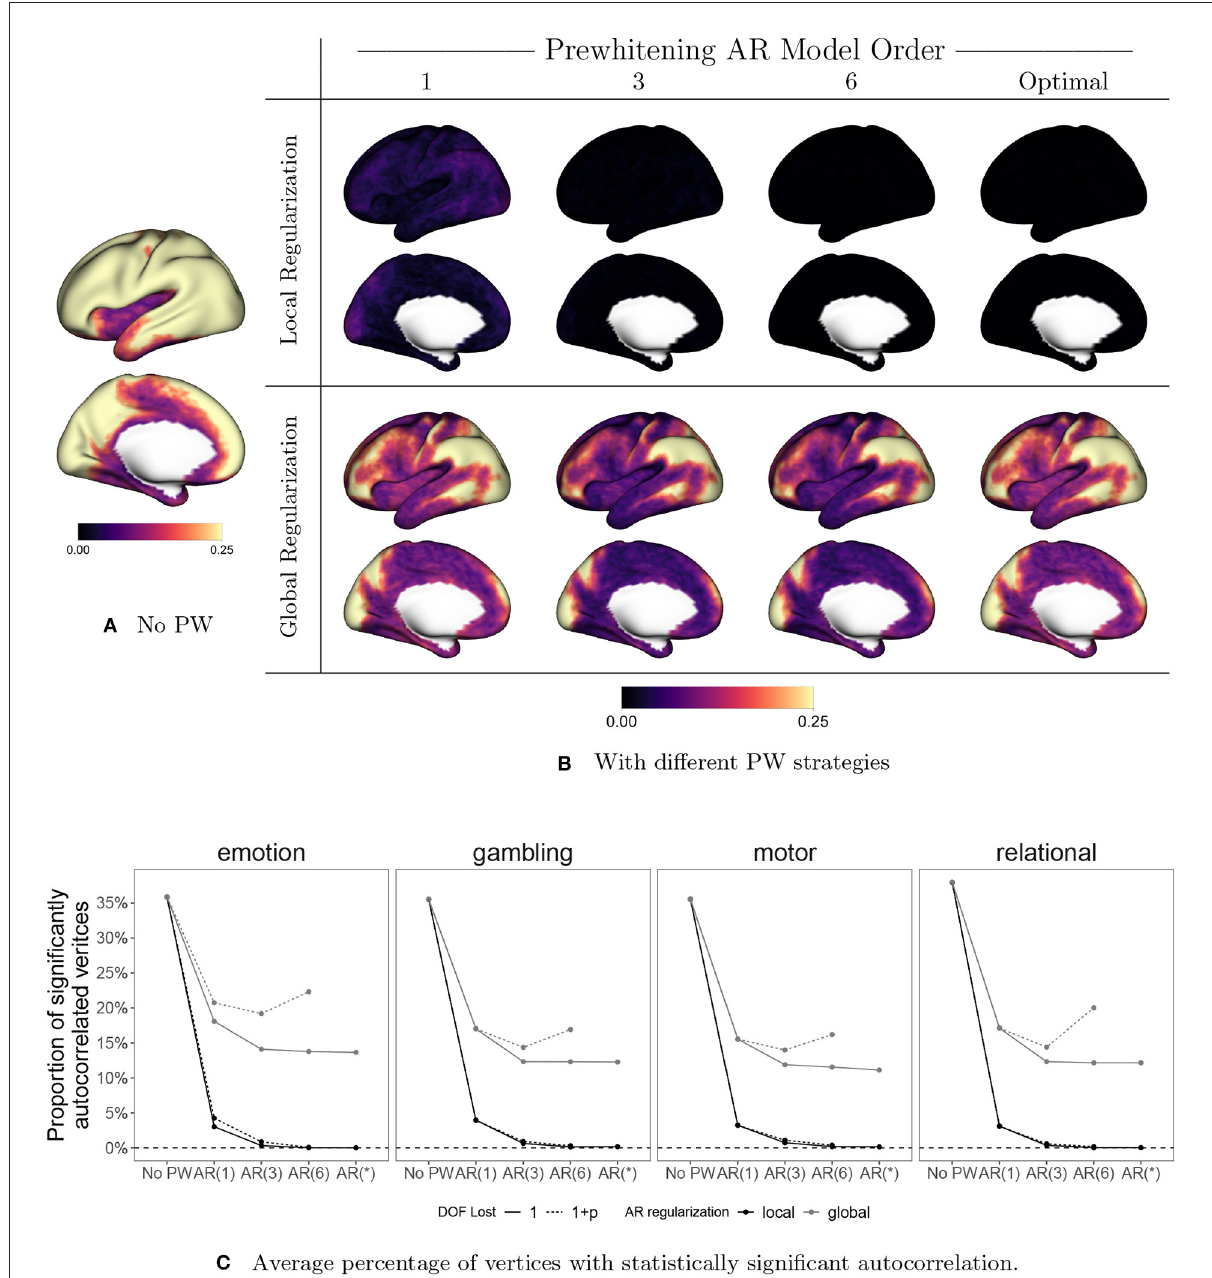
FIGURE10 The effect of prewhitening on the number of vertices with statistically significant autocorrelation. (A) Proportion of sessions exhibiting significant autocorrelation at each vertex before prewhitening. (B) Proportion of sessions exhibiting statistically significant autocorrelation after prewhitening. Eight different prewhitening strategies are shown, based on four different AR model orders (1, 3, 6, and optimal at each vertex) and two different regularization strategies for AR model coefficients (local smoothing vs. global averaging). Higher AR model order and allowing AR model coefficients to vary spatially results in substantially greater reduction in the number of vertices with statistically significant autocorrelation. Notably, allowing AR model coefficients to spatially vary has a greater effect than increasing AR model order. (C) Percentage of vertices with statistically significant autocorrelation, averaged across all subjects, sessions, and tasks. Dotted lines correspond to accounting for the degrees of freedom (DOF) lost when estimating AR coefficients. Adopting an AR model order of three or higher and allowing AR coefficients to vary spatially results in virtually no vertices with statistically significant